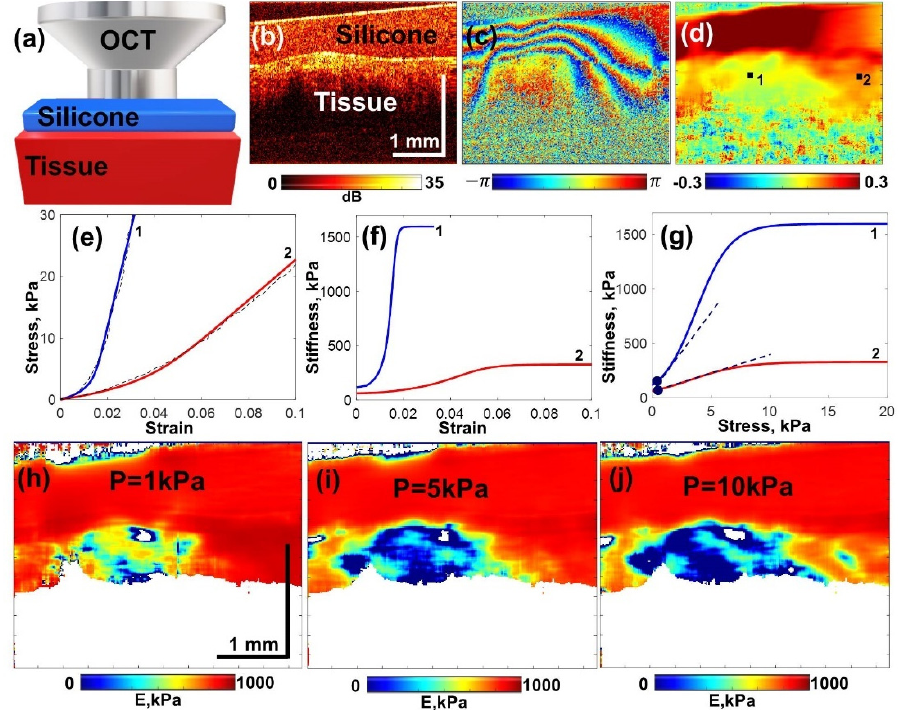
Figure 1. Procedures of evaluating linear and nonlinear elastic properties based on C-OCE with reference layers of highly linear silicone. ( a ) schematically shown tissue sample compressed by the OCT probe through the intermediate layer of reference silicone; ( b ) an example of a typical structural image obtained in such measurements; ( c ) an example of the derived color-coded interframe phase variation; ( d ) spatial distribution of strain obtained by estimating axial gradients of the interframe phase variation; ( e ) dashed lines show nonlinear stress–strain curves for positions corresponding to labels “1” and “2” in panel ( d ), the approximating functions are shown by the solid curves; ( f ) dependences of the tangent Young’s modulus (stiffness) on strain found by differentiation of the fitting curves from panel ( e ); ( g ) stiffness–strain dependences from panel ( f ) recalculated in stiffness–stress dependences, for which the slopes (see the dashed straight lines coming from the low-stress points ~0.5 kPa) correspond to the dimensionless nonlinearity parameter defined by Equation (4); panels ( h – j ) show how the reconstructed stiffness distribution evolved with increasing pressure for 1 kPa, 5 kPa, and 10 kPa, respectively.